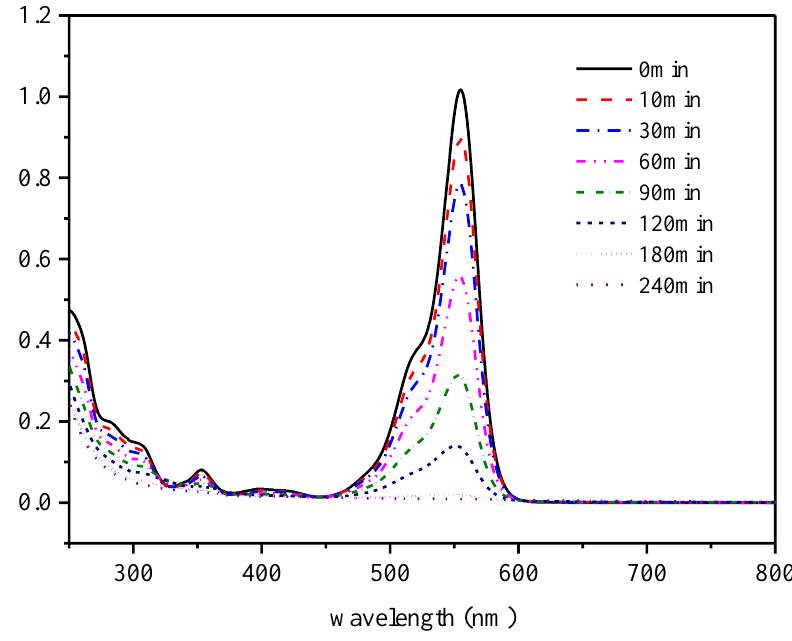
Figure 9. UV-vis spectra of RhB degradation ( 𝑐 0 = 200 mg/L, c H2O2 = 196 mmol/L, T = 55 °C, catalyst = 10 g/L, pH = 3).